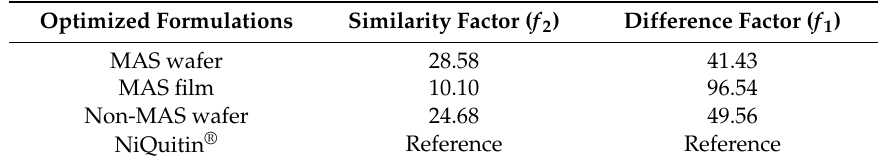
Table 4. Similarity ( f 2 ) and difference factor ( f 1 ) of optimized wafers and films compared to NiQuitin ® strips.